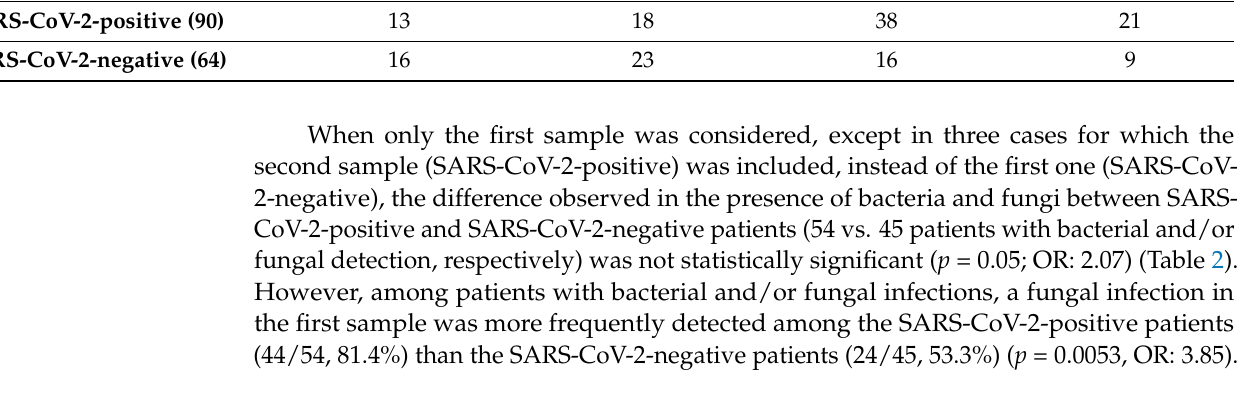
Table 2. Infectious agents detected in the first 154 lower respiratory tract